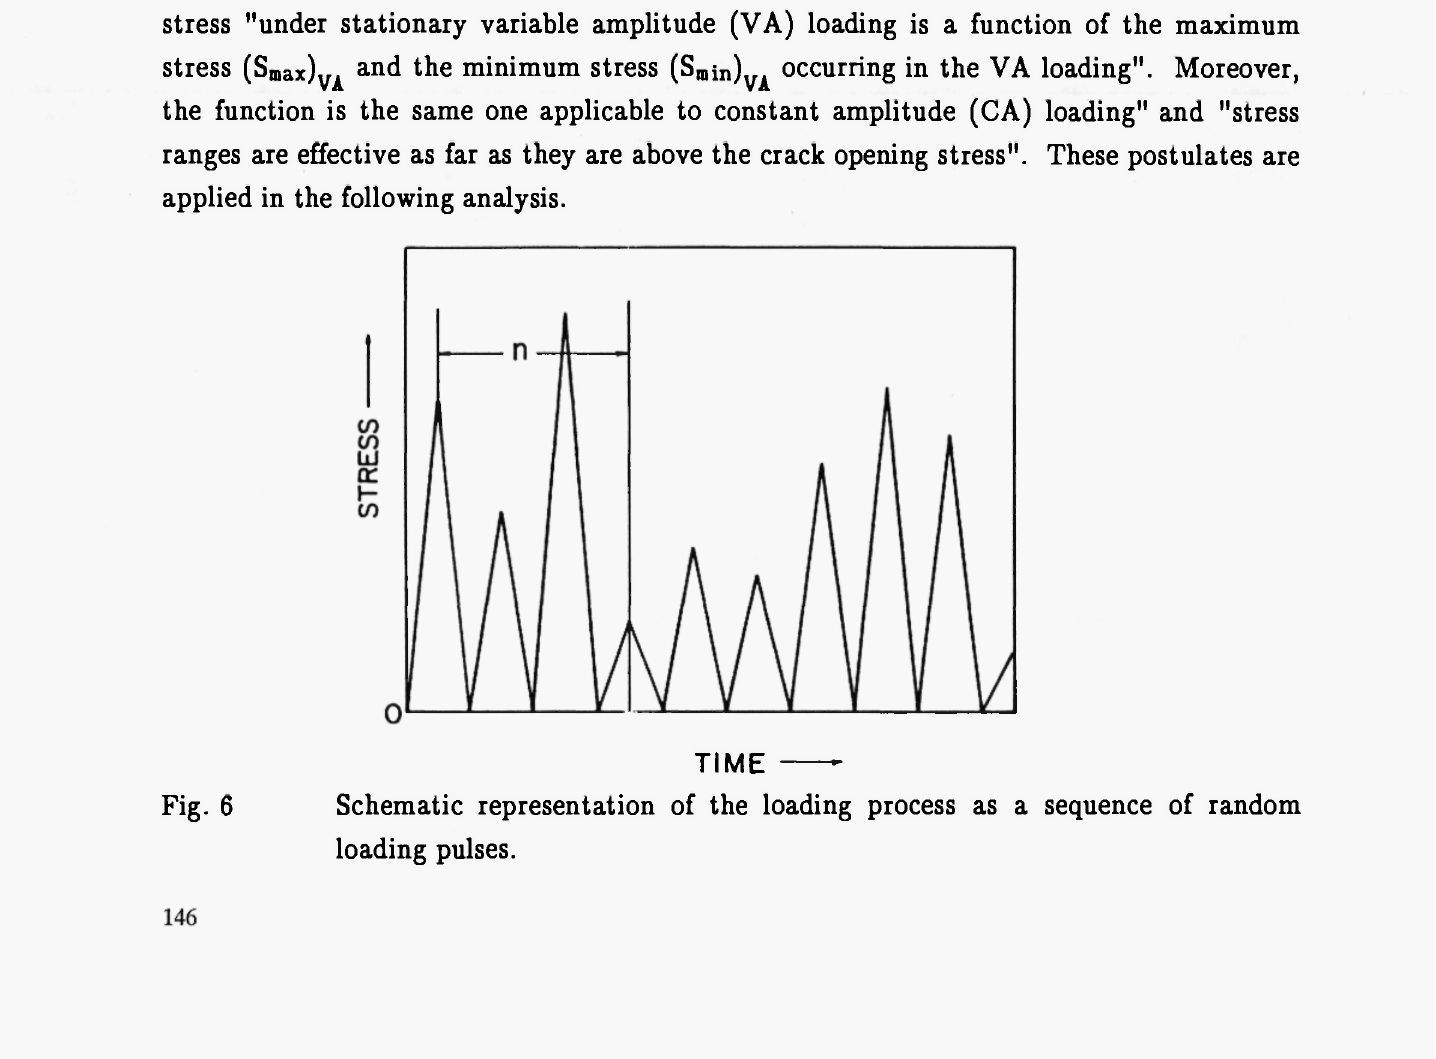
Fig. 6 Schematic representation of the loading process as a sequence of random loading